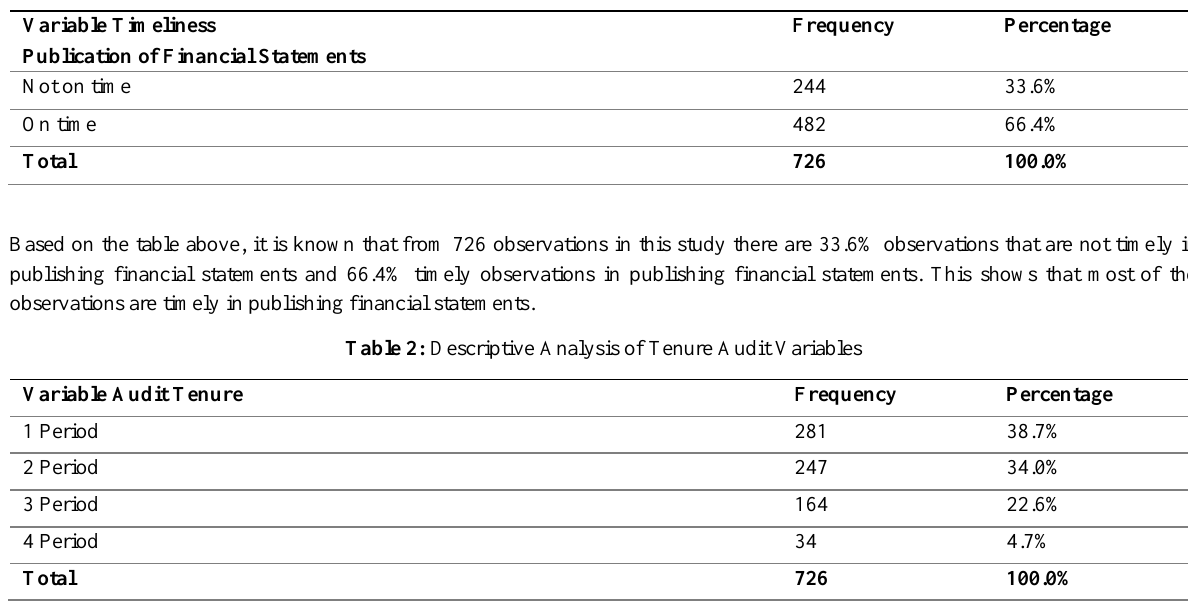
Table 1: Descriptive Analysis of the Timeliness of Financial Report Publication Variables